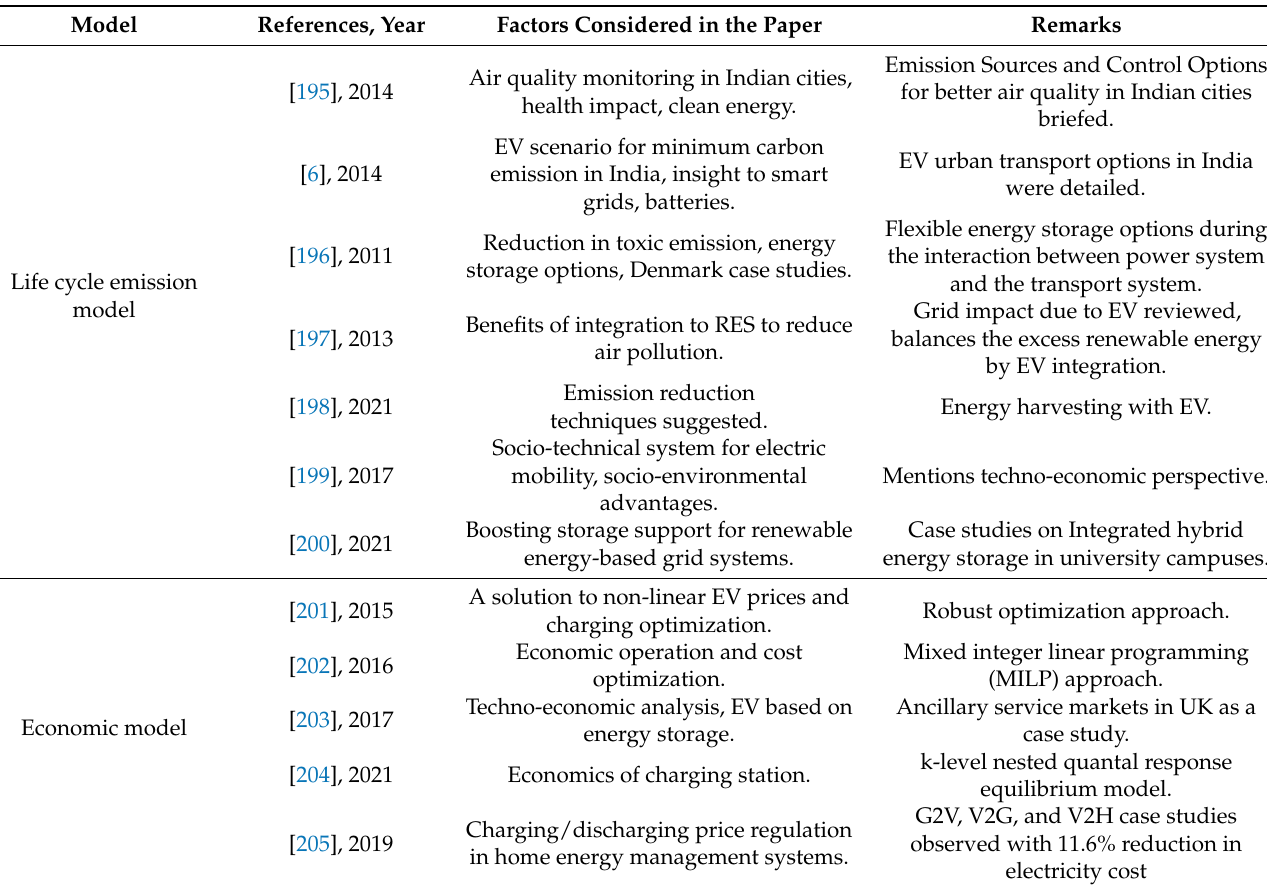
Table 5. Modelling approaches of electric vehicles during the grid